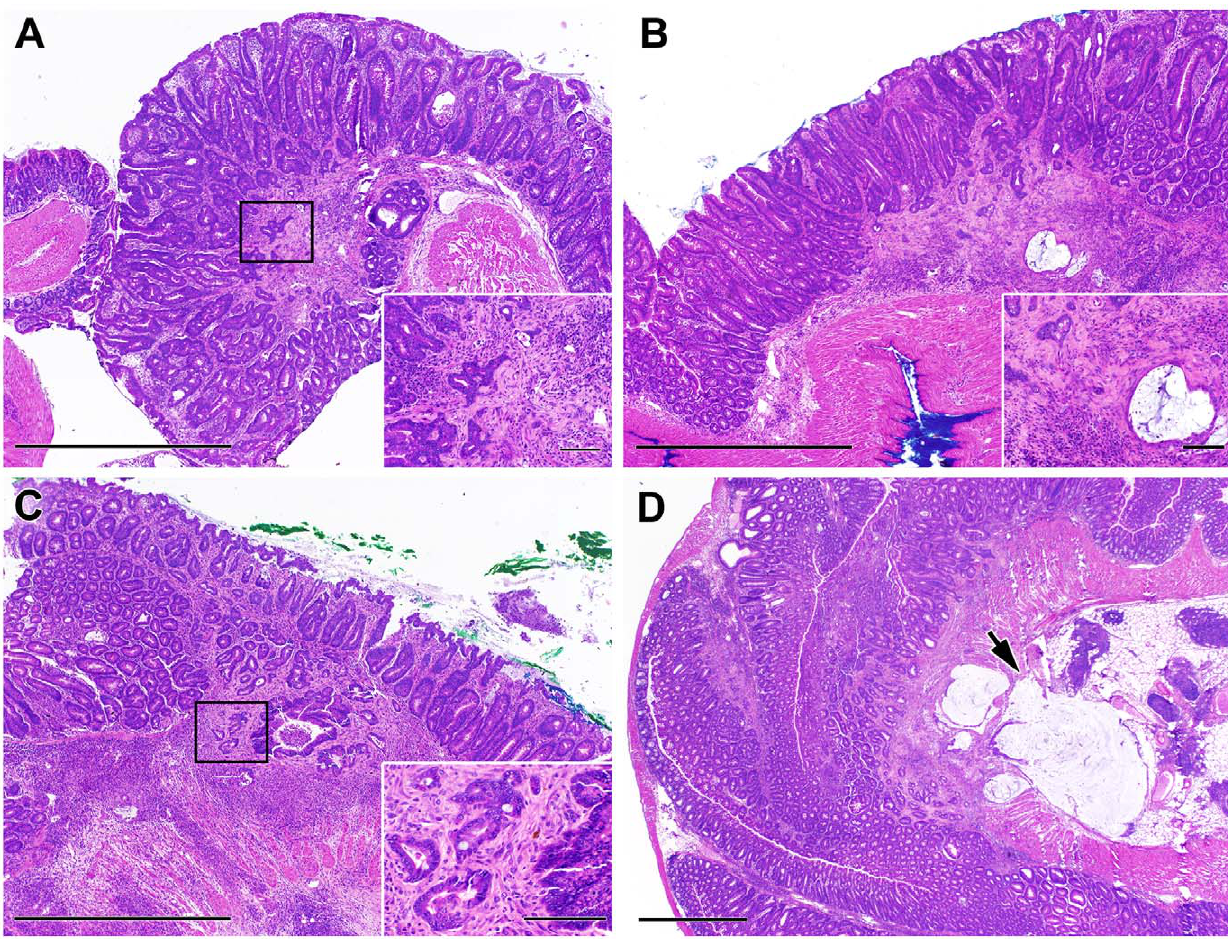
Figure 6. Colon histology and neoplasia in Helicobacter -infected and non-infected Il10 2 / 2 and DKO adult mice. Helicobacter-infected Il10 2 / 2 (A, B) and DKO mice (C, D) uniformly exhibited mucosal hyperplasia with prominent inflammatory infiltrates. Examples of neoplastic lesions seen in the long-term study are shown. The arrow in D indicates malignant glands that have invaded into the serosa. Bar represents 1 mm in the large panels and 100 m m in the insets.